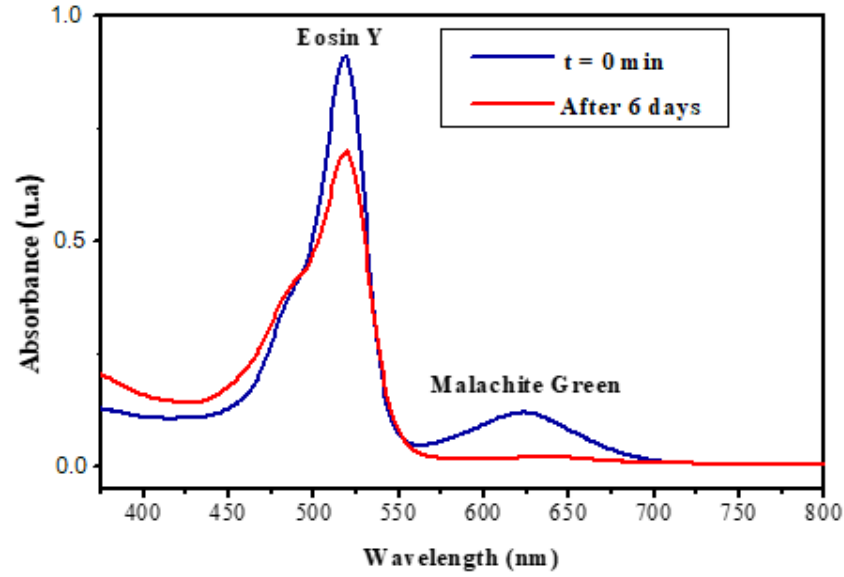
Figure 16. Retention of a mixture of dyes (malachite green at ν = 620 nm and eosin Y, at ν = 520 nm) by IPN (cellulose/polyHEMA) hydrogels. by IPN (cellulose/polyHEMA)